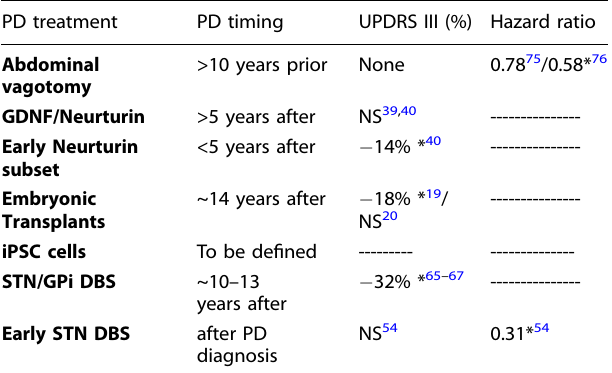
Fig. 1 Surgical methods of disease modi fi cation. Disease-modifying surgical strategies include cell replacement therapy, infusion or gene therapy of dopamine neurotrophic growth factors (both intraventricular and intraparenchymal administration), early subthalamic deep brain stimulation, and abdominal vagotomy. Table 1. Timing and outcome of surgical